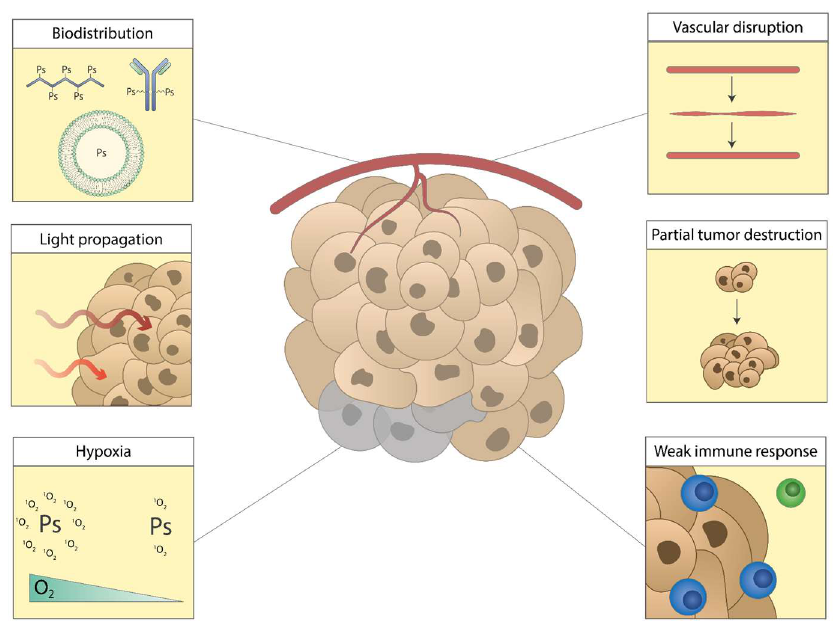
Figure 5. Current challenges of photodynamic therapy.